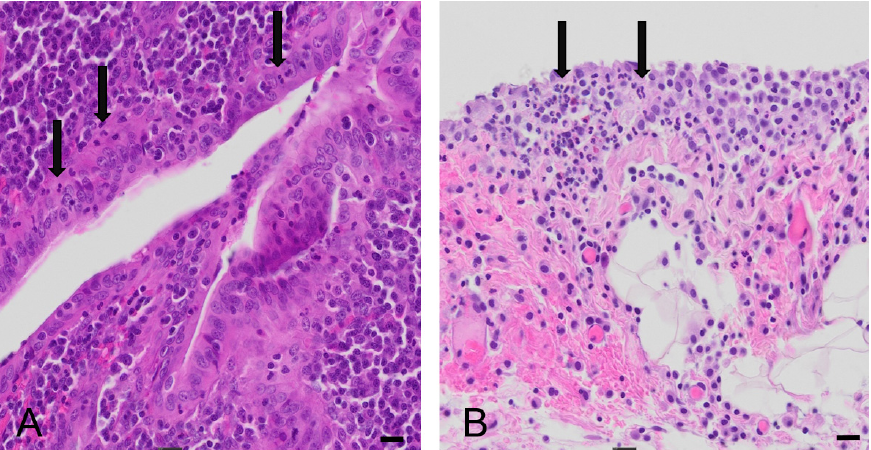
Figure 1. Histomorphological analysis of appendix vermiformis (H&E stain). Presence of acute inflammation in the mucosa of the appendix vermiformis ( A ) and in the periappendiceal fat tissue and serosa of the appendix ( B ). Arrows show neutrophilic granulocytes. Bar equals 50 µm.